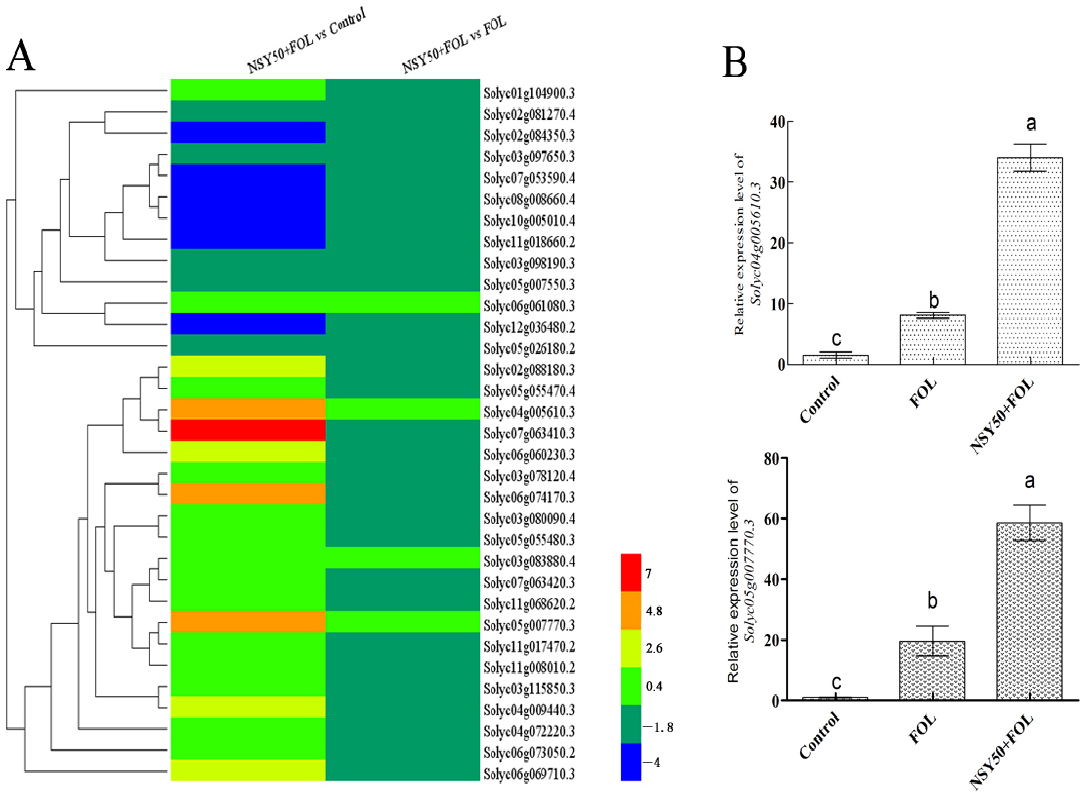
Figure 4. SlNAP1 and SlNAP2 were strongly induced by Fol. ( A ) Heatmap of 33 differentially expressed NAC transcription factors; ( B ) relative expression levels of SlNAP1 and SlNAP2 under different treatments. Different letters (a, b, and c) indicate statistically significant differences at p = 0.05 level.